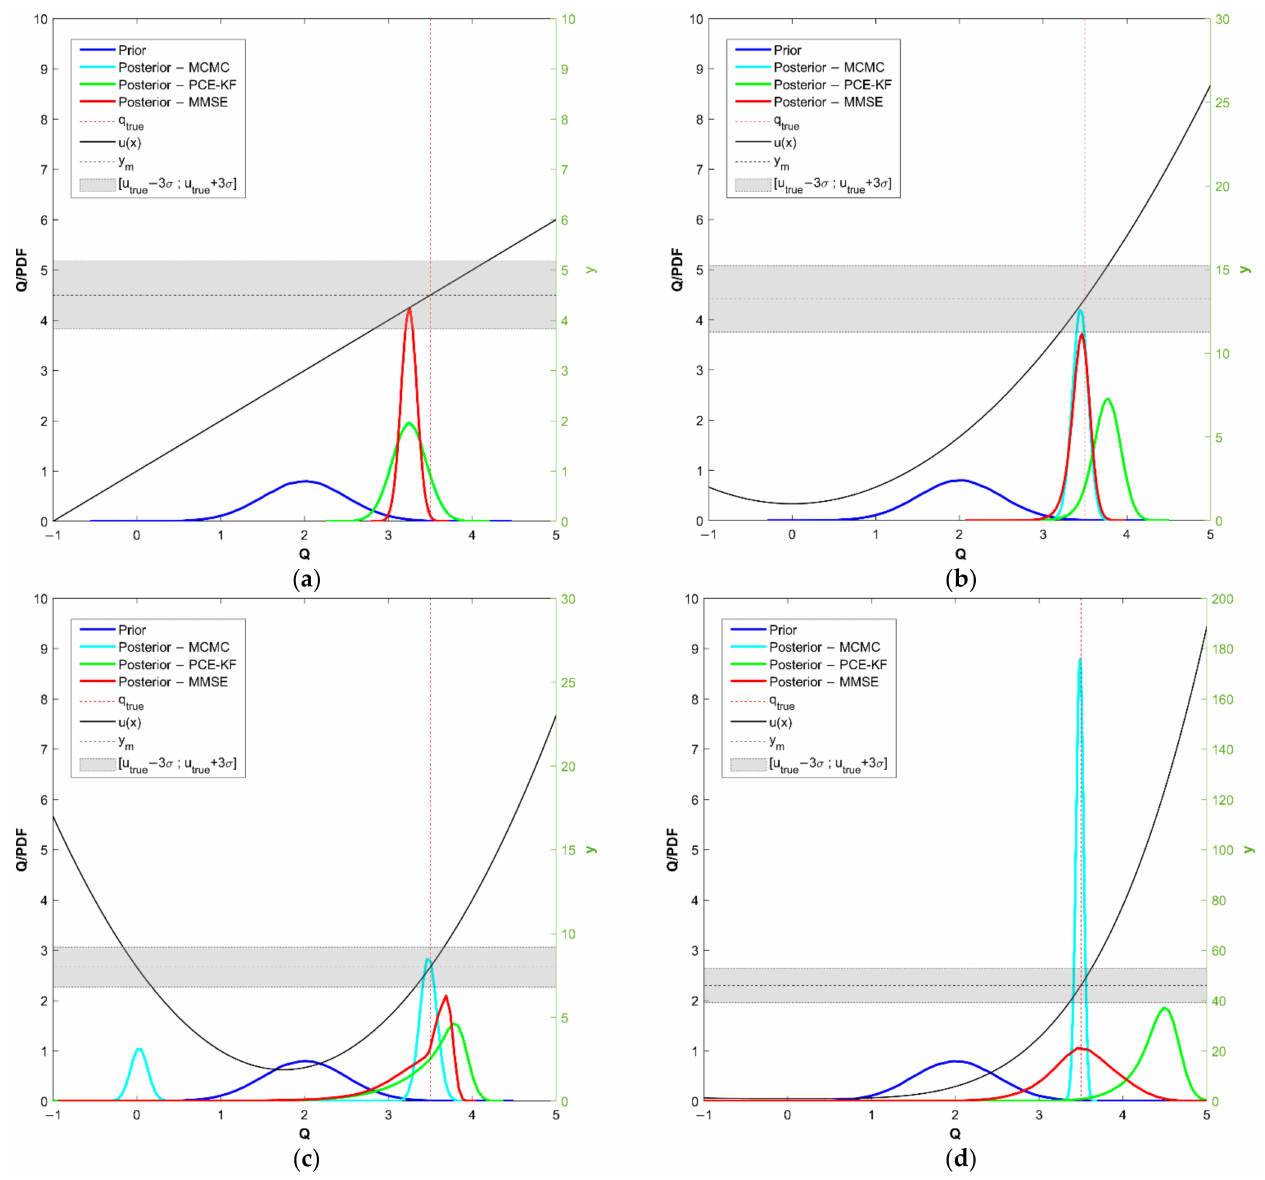
Figure 2. Comparison of different updating methods considering q true = µ + 3 σ : ( a ) Model 1, ( b ) Model 2a, ( c ) Model 2b and ( d ) Model 3. In each figure, the following are reported: the prior PDF (in blue); the posterior PDFs obtained via MCMC (in cyan), via PCE-KF (in green) and via NL-MMSE (red solid line); the true value of the parameter q true (red dashed line); the model response u ( q ) (black solid line); the measurement y m (black dashed line); the ± 3 σ ε region of the measurement (grey